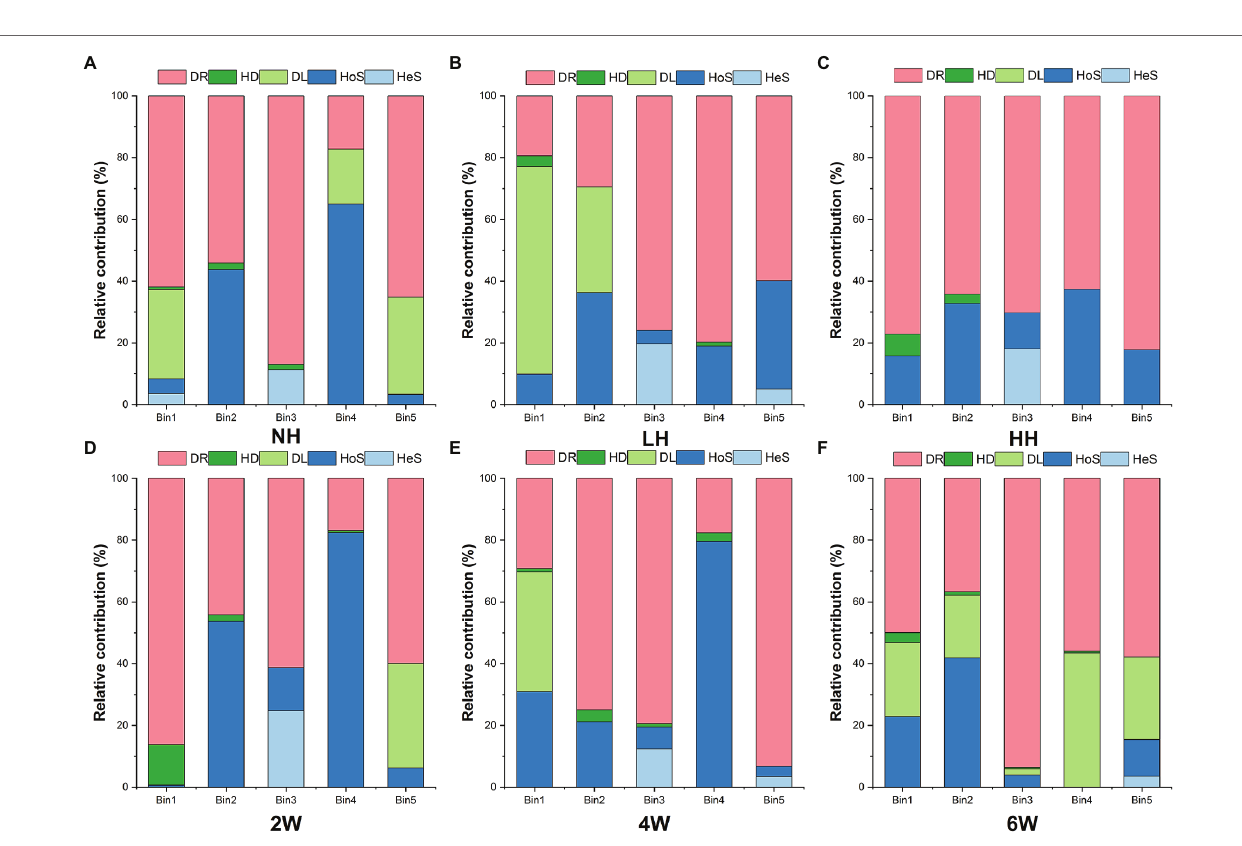
FIGURE 5 | Relative abundance of each bin across the different treatment groups (A - C : different herbivory intensities; D - F : different time since herbivore removal). Only the five most abundant bins are shown in this figure. Source data can be found in Supplementary Table S4